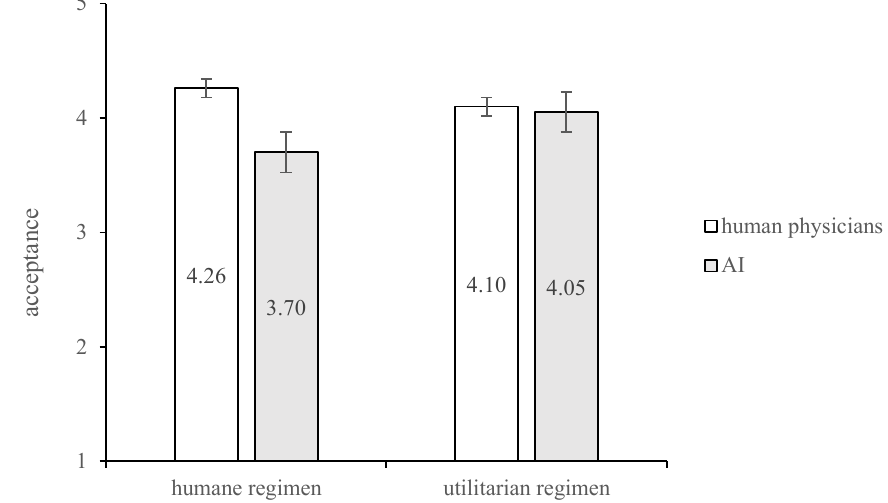
Figure 2. Interaction of Human vs. AI and the type of regimen on acceptance.